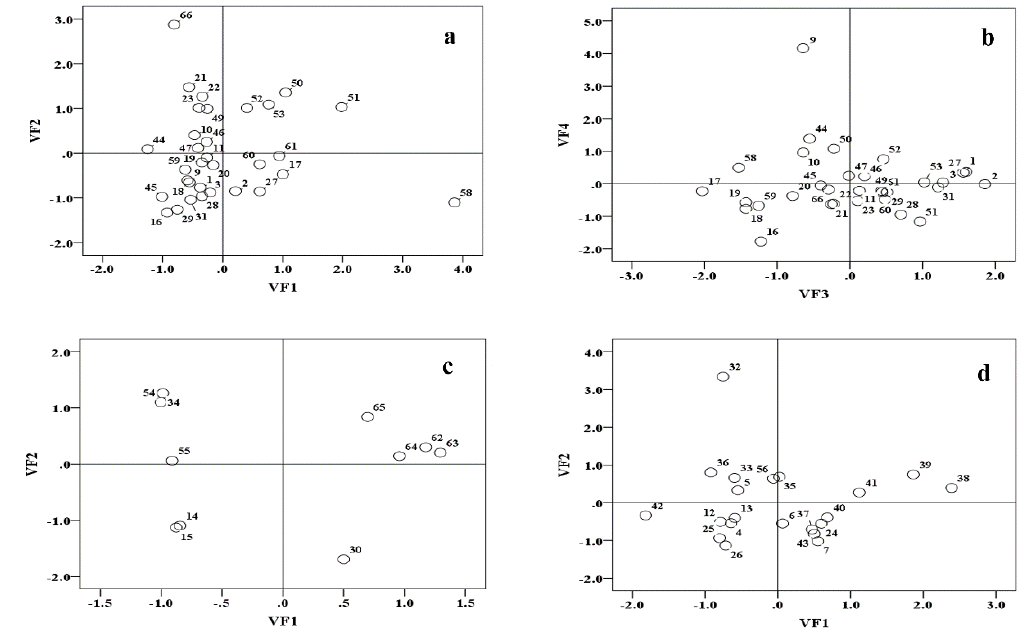
Figure 8. Scatter plot of the scores for the VFs for group A ( a , b ); group B ( c ) and group C ( d ). Note : Each number was short for each sampling site.